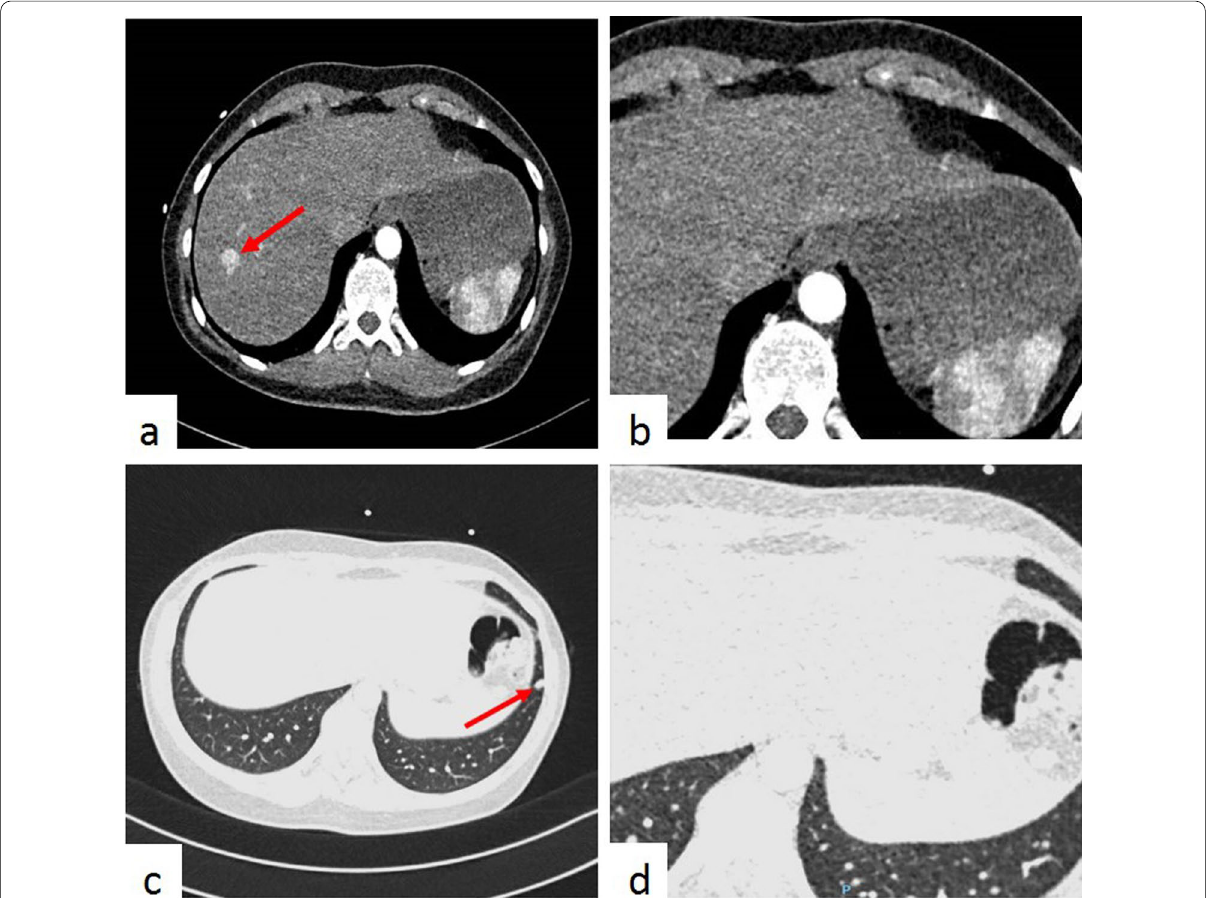
Fig. 1 Examples of a moderate liver and a moderate lung IF in different field of views. a An example of a moderate liver IF (a hypervascular lesion) in a full field of view (FOV) with a ‘soft tissue’ window level (C:40 W:400). b The same CTA as a , but in a small FOV, in which the moderate liver IF falls beyond the area of this reconstruction. c An example of a moderate lung IF (a lung nodule) in a full FOV with a ‘lung’ window level (C:‑600 W:1200). d The same CTA as c , but in the small FOV, in which the lung nodule falls beyond the area if this